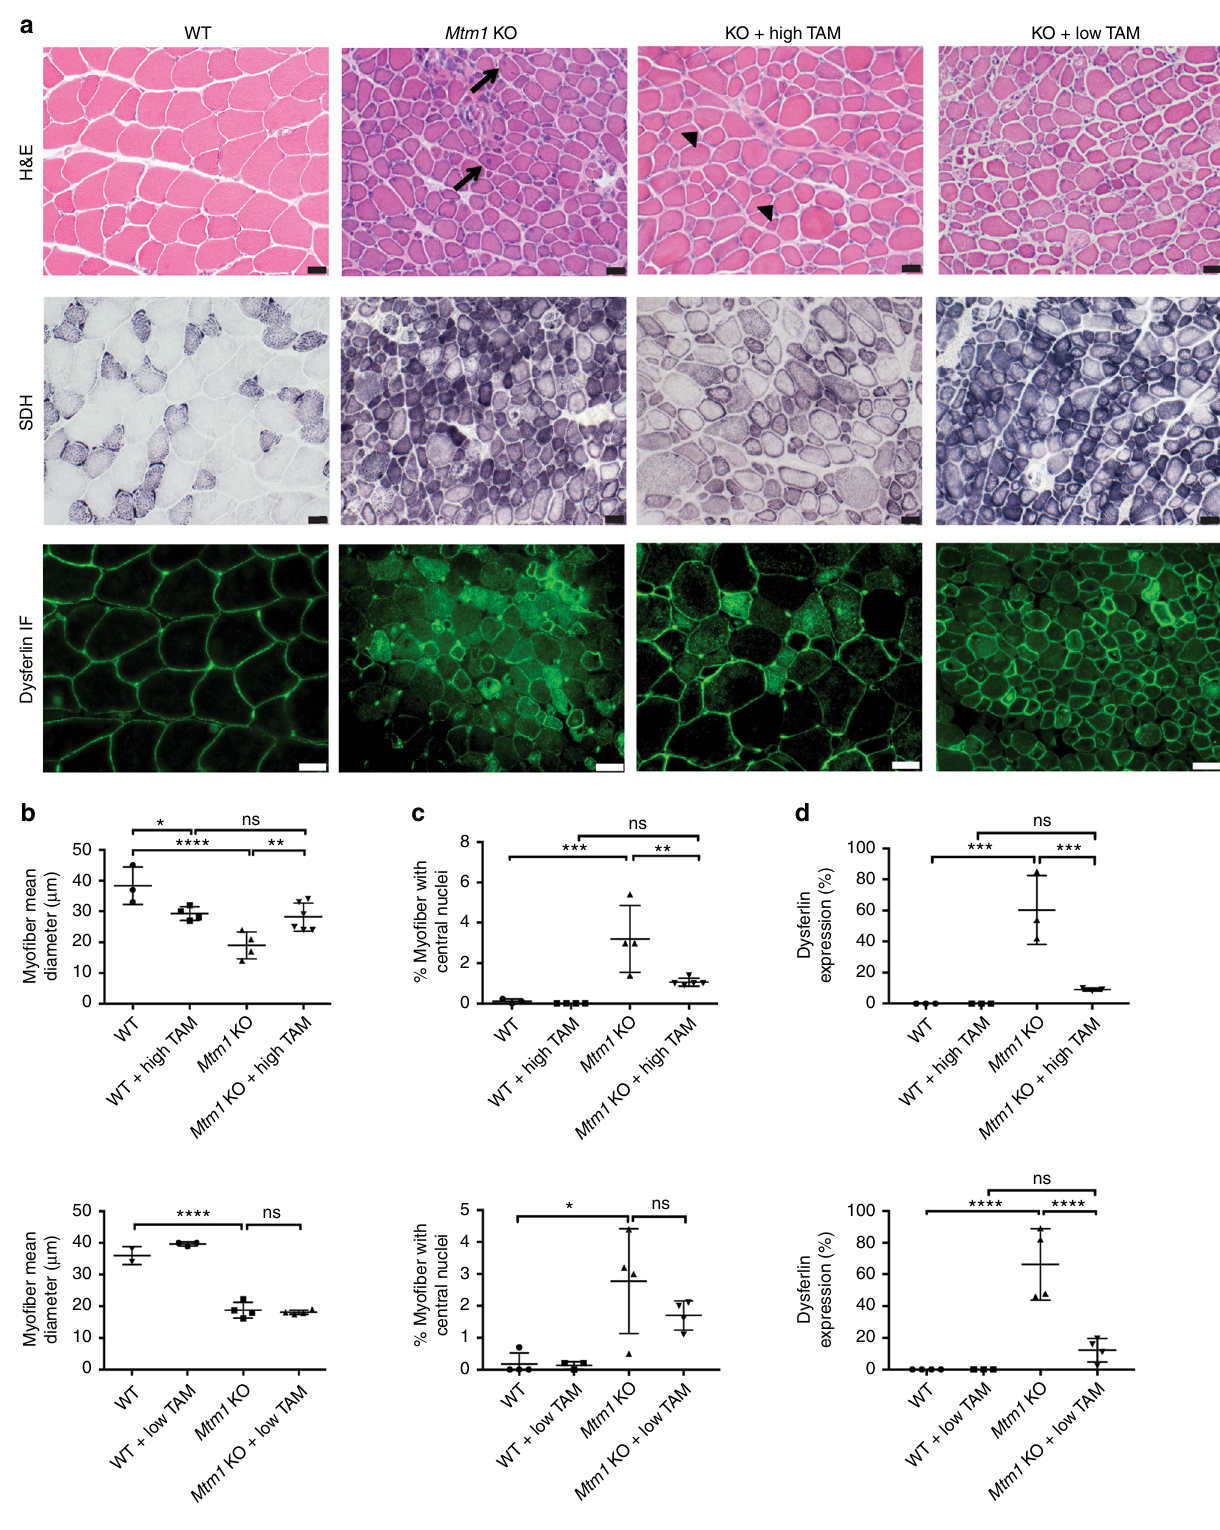
mice exhibited signi fi cantly reduced maximal calcium release a trend toward increase, particularly in the animals started at during both twitch and tetanic stimulation compared to fi bers 14 days (Fig. 3g, h), low-dose tamoxifen treatment did not from wild-type littermates. Importantly, high-dose tamoxifen signi fi cantly improve triad number (Fig. 4b). Taken together with treatment signi fi cantly increased maximal twitch and tetanic the histopathological analyses, these data indicate that tamoxifen calcium release in fi bers from MTM mice (Fig. 4c – e), consistent results in a dose dependent rescue of key skeletal muscle structures with the observed normalization of triad number. While there was and functions that are defective in untreated MTM mice. NATURE COMMUNICATIONS| (2018) 9:4849 |DOI: